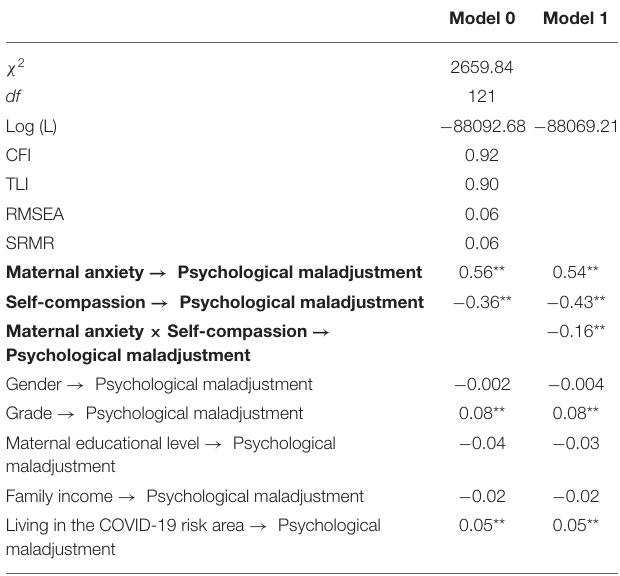
TABLE 3 | Model fit indices and regression coefficients for the latent moderated